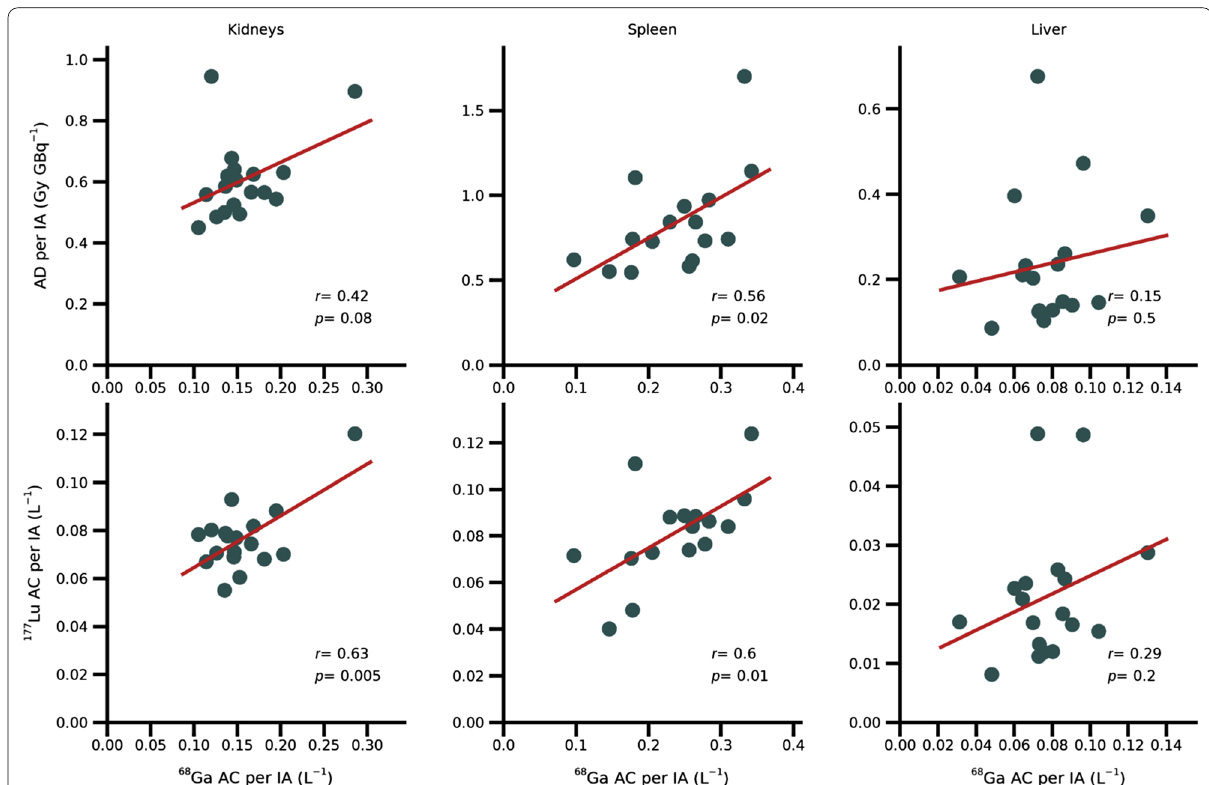
Fig. 2 Observed relationship between [ 68 Ga]Ga-DOTA-TATE and [ 177 Lu]Lu-DOTA-TATE for organs. Lutetium-177 absorbed dose per injected activity (upper row) and 177 Lu activity concentration per injected activity (lower row) are shown as a function of the 68 Ga activity concentration per injected activity for kidneys (left column), spleen (middle), and liver (right)